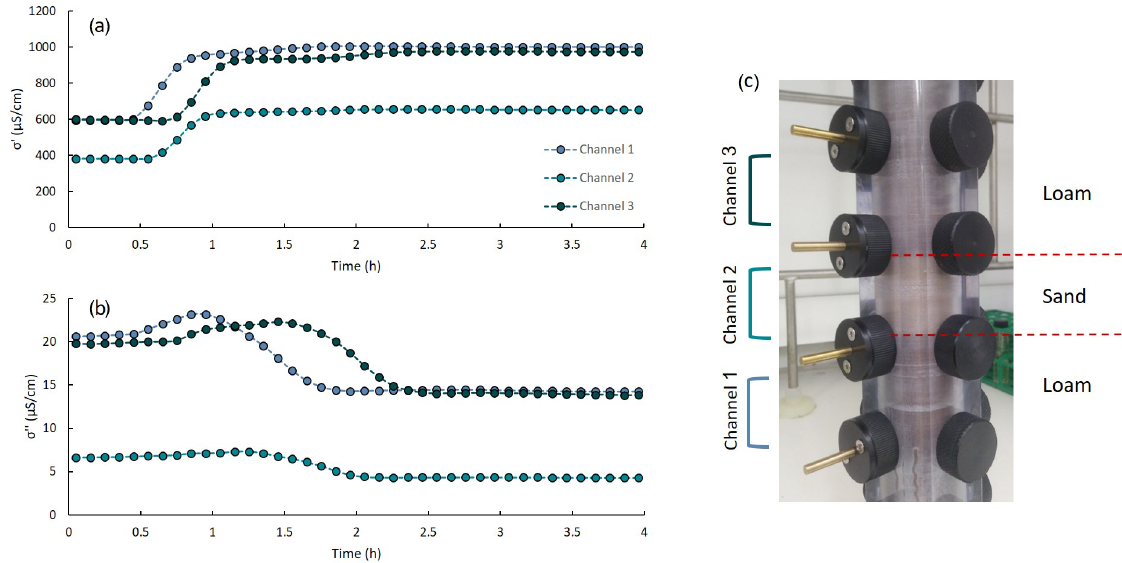
Figure 7. The real (a) and imaginary (b) components of the complex conductivity at 1Hz vs. time, for the heterogeneous profile. Panel (c) shows the heterogeneous profile: a sandy layer was packed between the two middle electrodes (channel